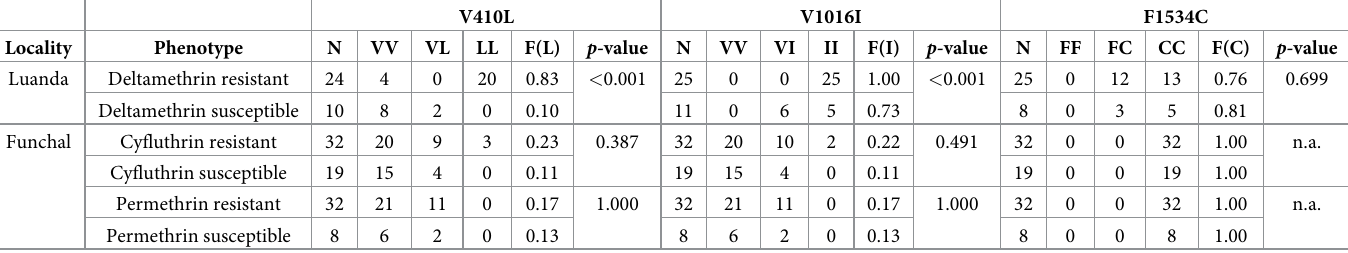
Table 2. Knockdown resistance genotype-phenotype associations in Ae . aegypti populations from Luanda (Angola) and Funchal (Madeira